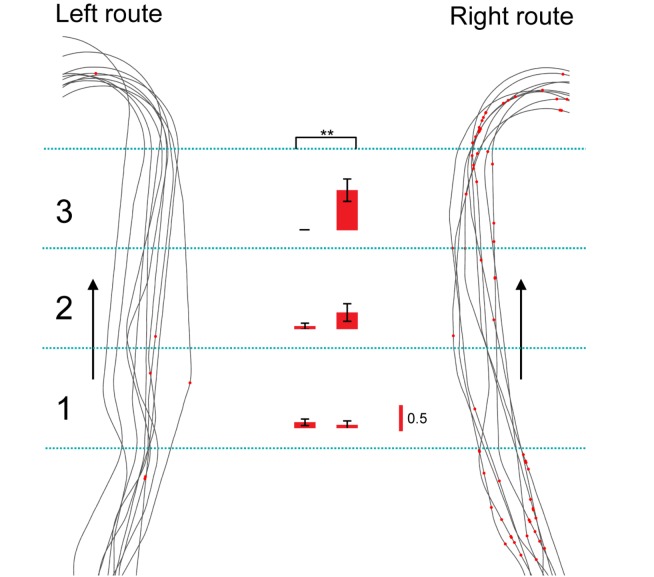
Another example of a route-dependent neuron in the VN task. Red dots on trails indicate neuronal spikes. Left and right histograms indicate mean firing rates in the three zones in the common central hallway (1–3) in the left and right routes, respectively. Calibration in the right bar indicates 0.5 spikes/s. ∗∗p < 0.01.